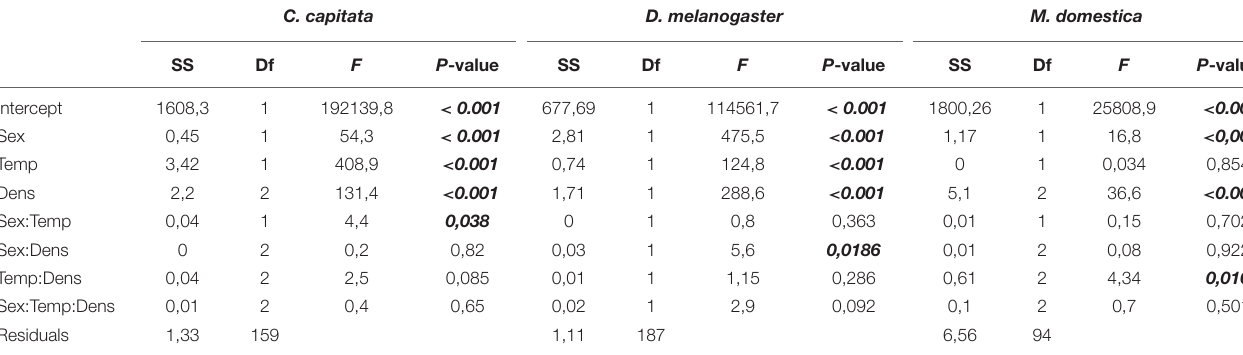
TABLE 2 | Effects of sex, temperature, density, and their interactions on wing centroid size tested by Type III